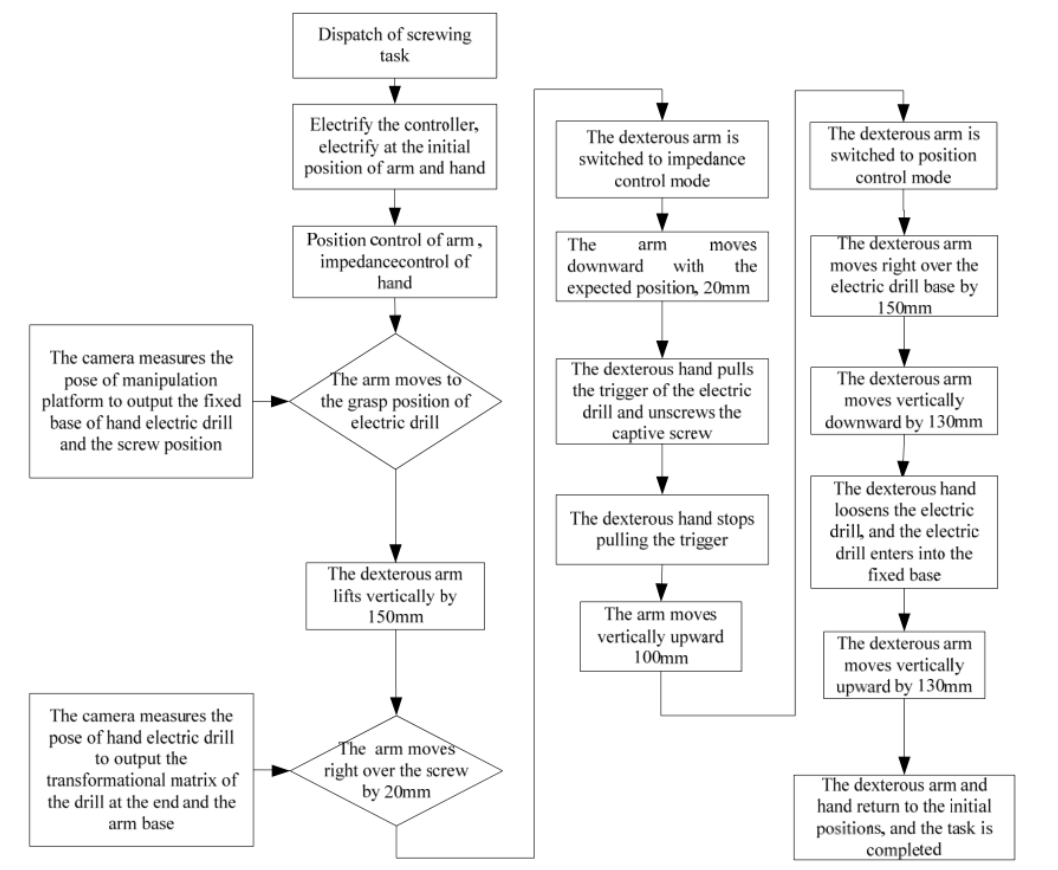
Figure 10. Operation Flow of Rotating the J599 Electric Connector by the Manipulator Hand